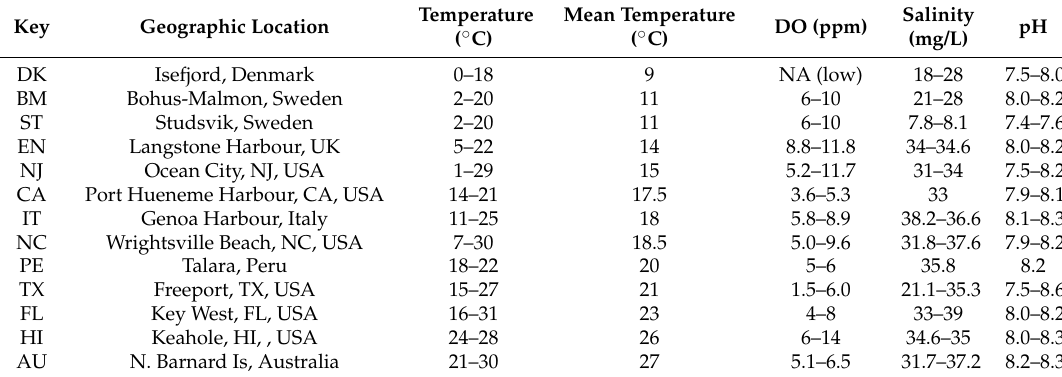
Table 2. Exposure sites and basic seawater data ordered by mean seawater temperature [11].